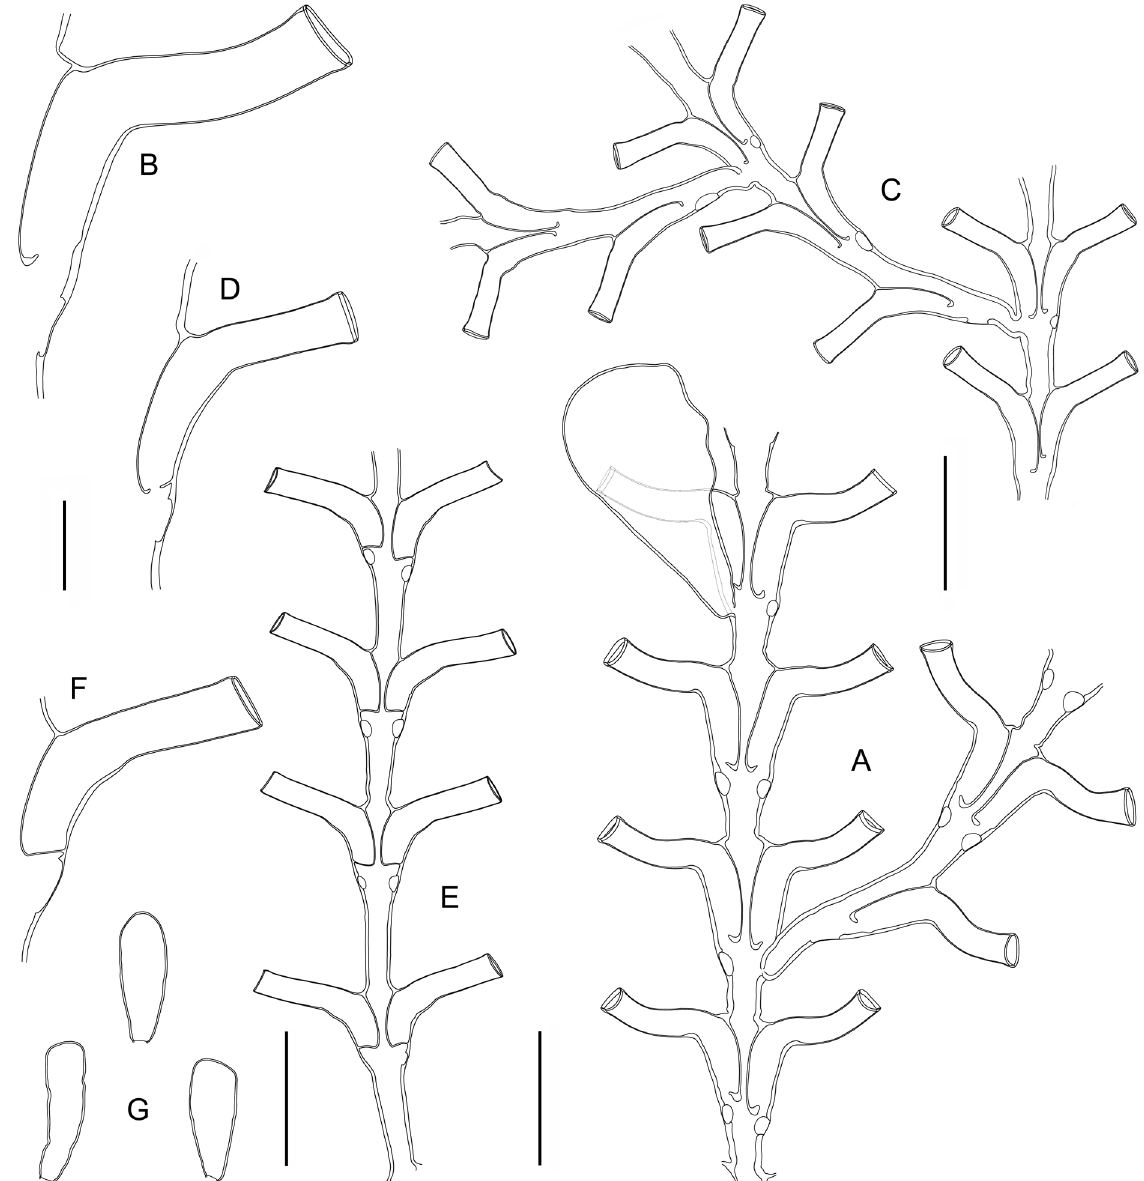
Fig. 2. — A – B . Caledoniana alata gen. et sp. nov. A . Portion of fertile stem (note gonotheca above) and basal part of a side branch, showing positions of hydrothecae. B . Hydrotheca. — C – D . Caledoniana decussata gen. et sp. nov. C . Portion of stem with first and second order side branches from region of colony with coplanar hydrothecae, showing their relative position. D . Hydrotheca. — E – G . Caledoniana microgona gen. et sp. nov. E . Portion of stem. F . Hydrotheca. G . Three gonothecae. Scale bars: A, C, E, G = 3 mm; B, D, F = 1